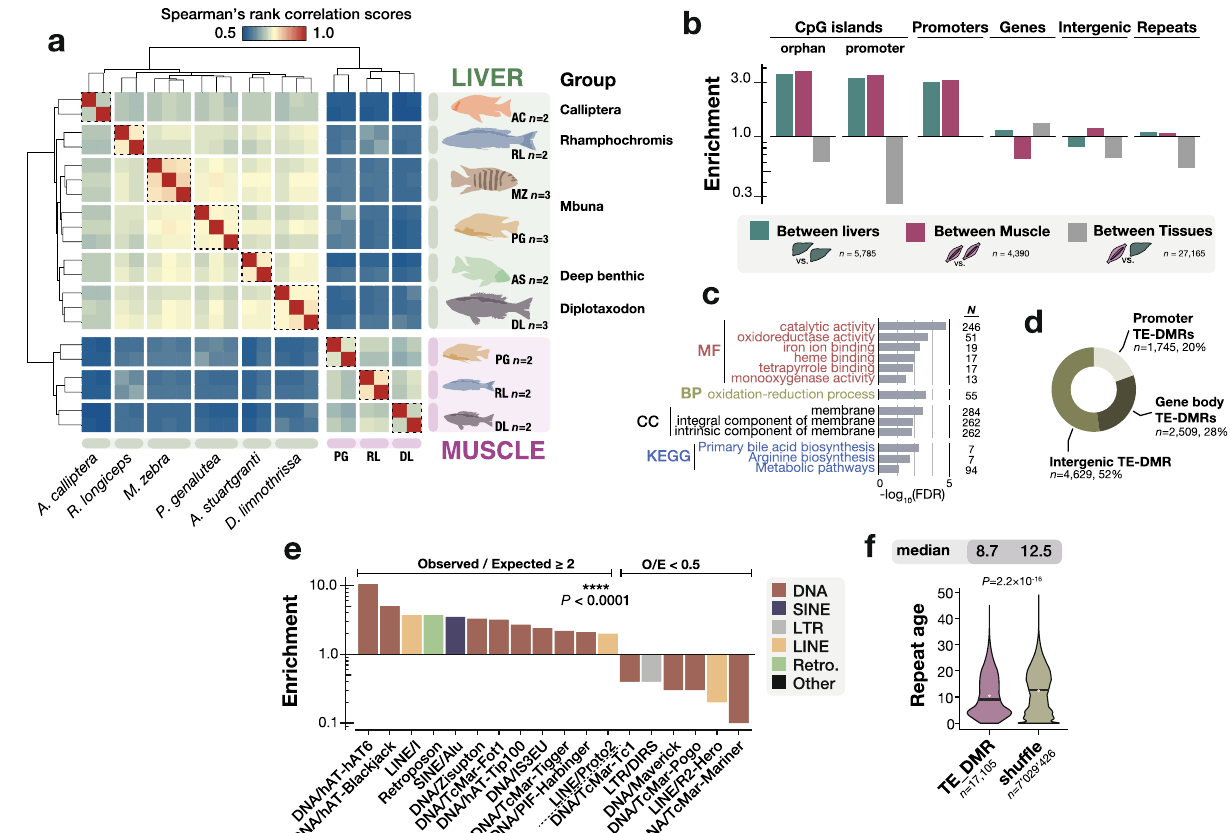
Fig. 2 Species-speci fi c methylome divergence in Lake Malawi cichlids is enriched in promoters, CpG-islands, and young transposons. a Unbiased hierarchical clustering and heatmap of Spearman ’ s rank correlation scores for genome-wide methylome variation in Lake Malawi cichlids at conserved CG dinucleotides. Dotted boxes group samples by species within each tissue. b Observed/Expected ratios (O/E ratio, enrichment) for some genomic localisations of differentially methylated regions (DMRs) predicted between livers (green) and between muscles (purple) of three Lake Malawi cichlid species, and between tissues (within-species, grey); χ 2 tests for between categories ( p < 0.0001), for O/E between liver and muscle DMRs ( p = 0.99) and between Liver + Muscle vs Tissues (p = 0.04). Expected values were determined by randomly shuf fl ing DMRs of each DMR type across the genome (1000 iterations). Categories are not mutually exclusive. c Gene ontology (GO) enrichment for DMRs found between liver methylomes localised in promoters. GO terms: Kyoto Encyclopaedia of Genes and Genomes (KEGG), molecular functions (MF), cellular component (CC), and biological processes (BP). Only GO terms with FDR < 0.05 shown. N indicates the number of genes associated with each GO term. Only GO terms with p < 0.05 (Benjamini − Hochberg false discovery rate [FDR]-corrected p -values) are shown. d Genomic localisation of liver DMRs containing repeats/transposons (TE-DMRs). e . O/E ratios for species TE-DMRs for each TE family. Only O/E ≥ 2 and ≤ 0.5 shown. χ 2 tests, p < 0.0001. f Violin plots showing TE sequence divergence (namely, CpG-adjusted Kimura substitution level as given by RepeatMasker) in M. zebra genome for species TE-DMRs, TEs outside species DMRs ( ‘ outside ’ ) and randomly shuf fl ed TE-DMRs (500 iterations, ‘ shuf fl e ’ ). Mean values indicated by red dots, median values by black lines and shown above each graph. Total DMR counts indicated below each graph. Two-sided p -values for Kruskal – Wallis test are shown above the graph. DMR, differentially methylated region; TE, repeat/transposon regions; CGI, predicted CpG (Supplementary Fig. 9d), consistent with species-speci fi c func- tional liver transcriptome activity.